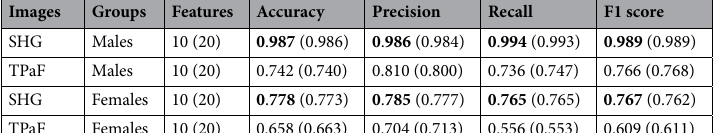
Images Groups Features Accuracy Precision Recall